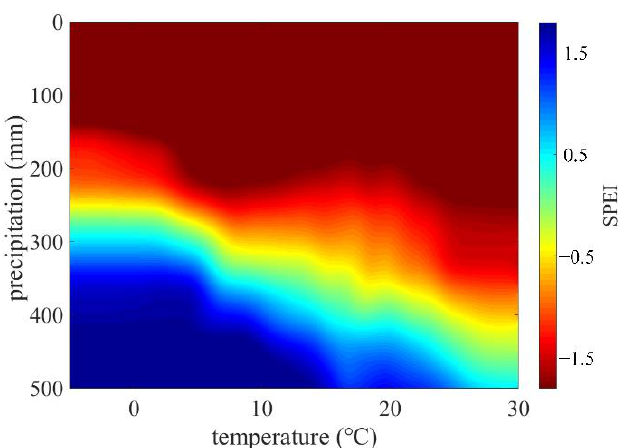
Figure 11. Dependence of the downscaled SPEI on precipitation and temperature.